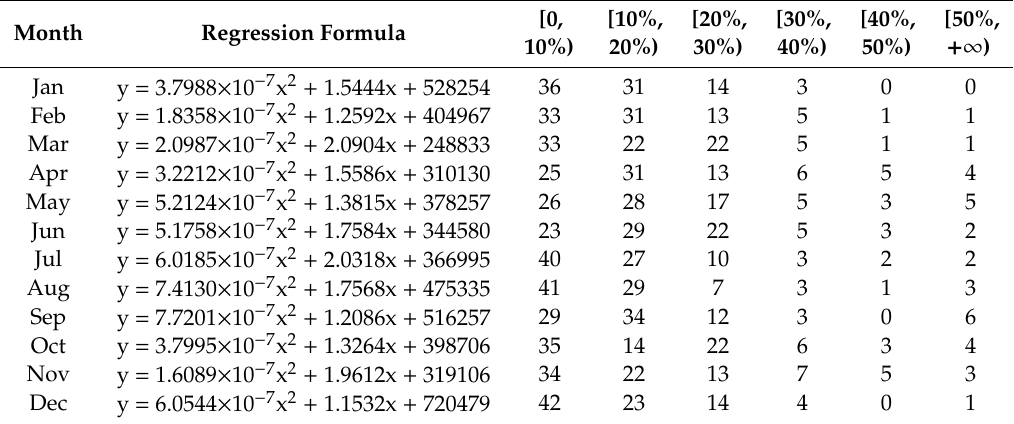
Table 3. Distribution of absolute relative